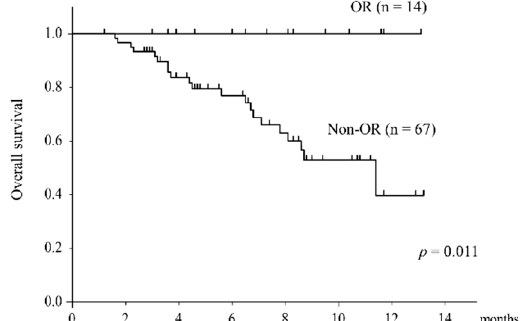
Figure 1. Overall survival stratified by radiological response according to Response Evaluation Criteria in Solid Tumors (RECIST). Kaplan–Meier curves for OR (objective response) and non-OR. There was a significant difference in OS between the two groups ( p = 0.011).